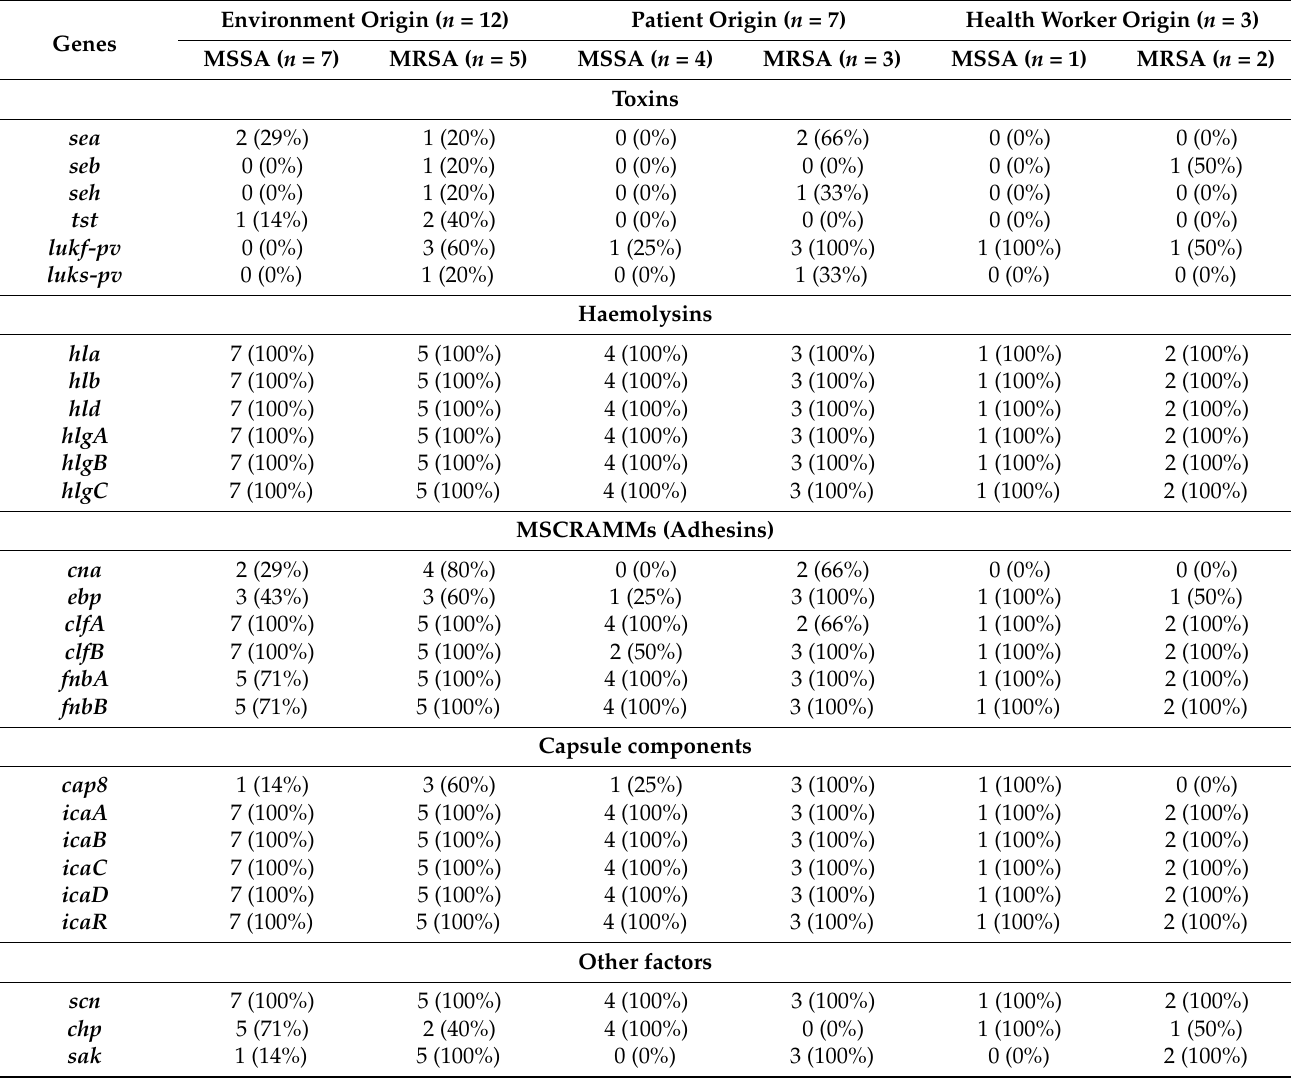
Table 2. Distribution of virulence genes on the 22 sequenced